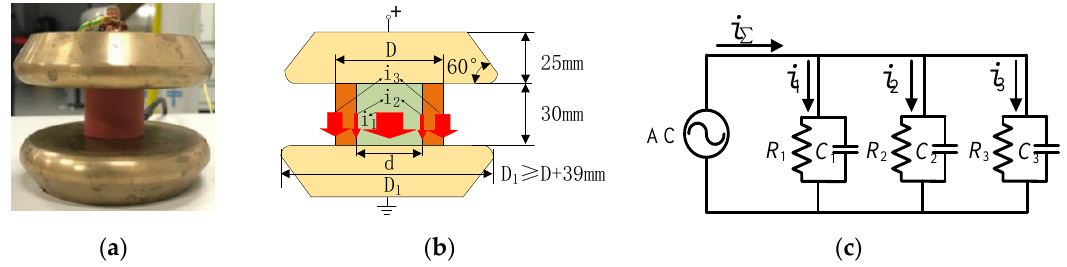
Figure 3. Principle of the traditional current sensor: ( a ) Conventional electrode; ( b ) Conventional electrode model; ( c ) Equivalent lumped circuit.